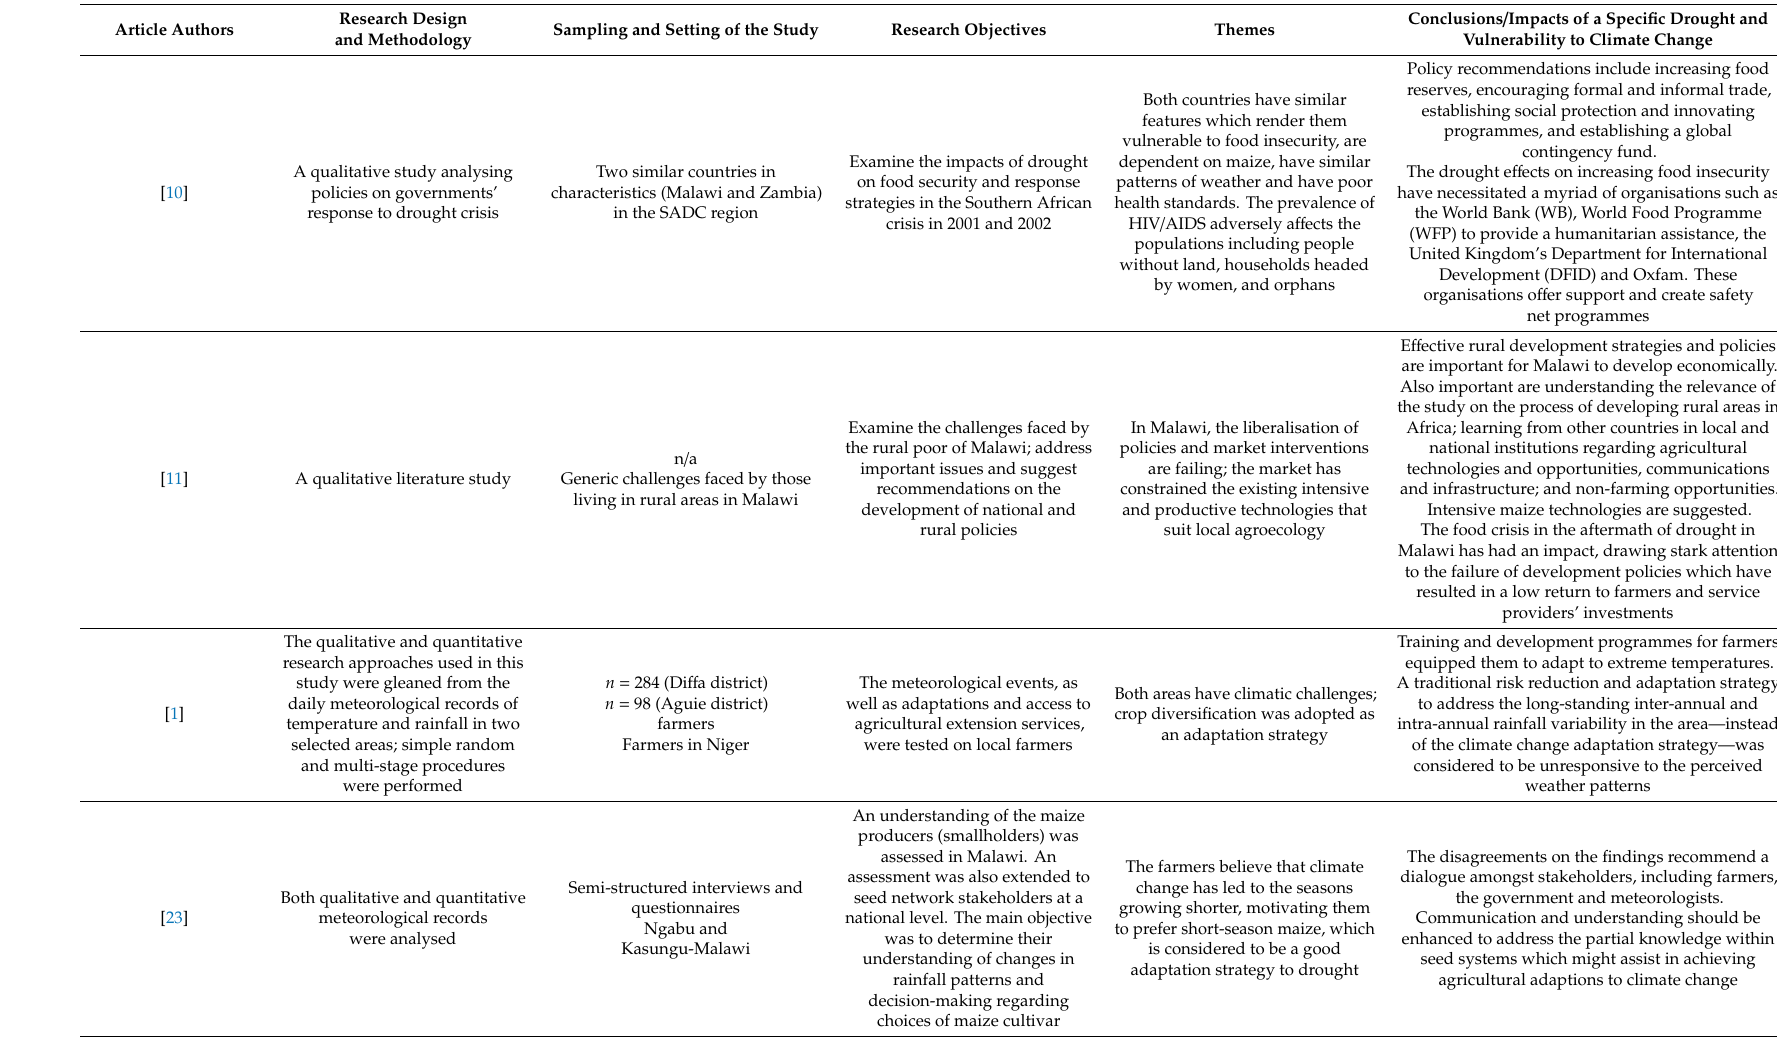
Table 1. Characteristics of the